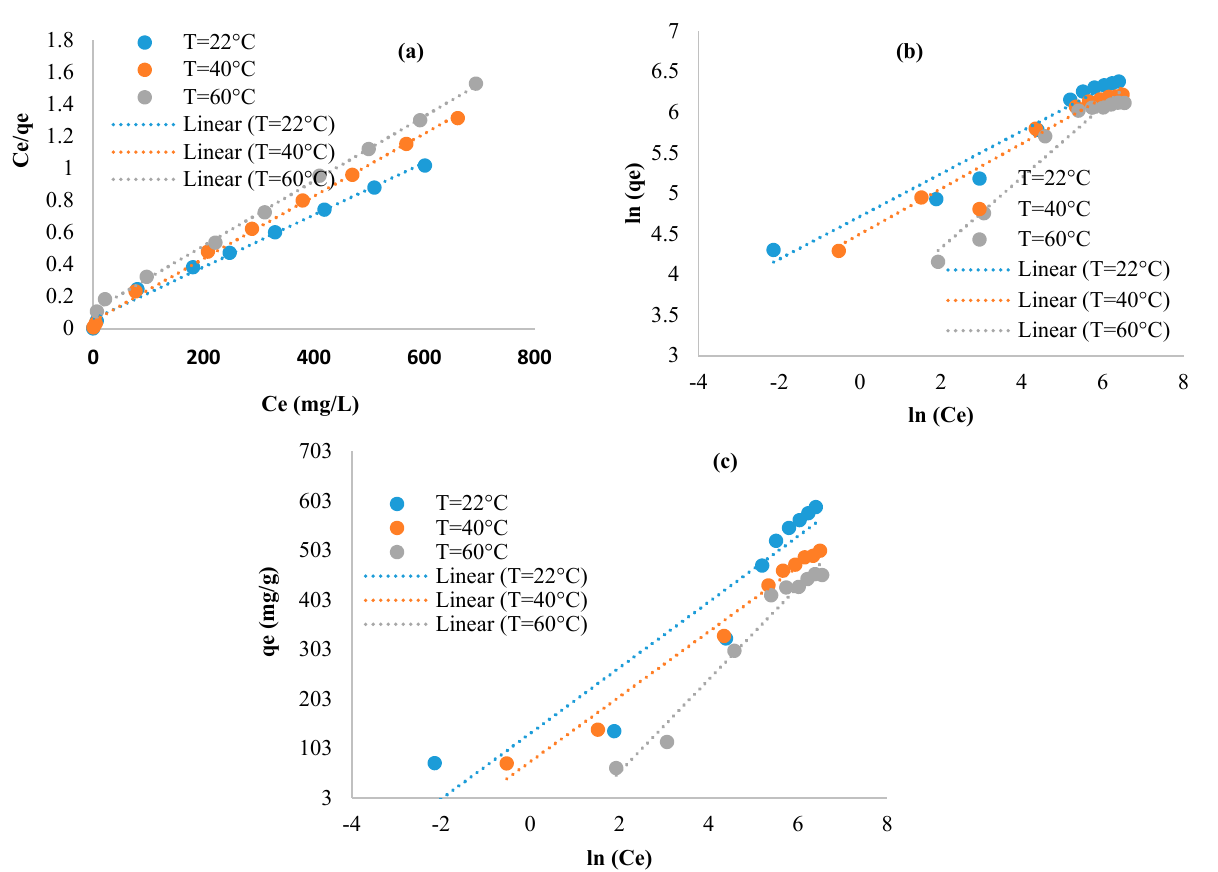
Figure 8. Isotherms data modeled using: ( a ) Langmuir, ( b ) Freundlich, and ( c ) Temkin. Table 2. Summarized Langmuir, Freundlich, and Temkin parameters for the grafted samples. Langmuir Freundlich